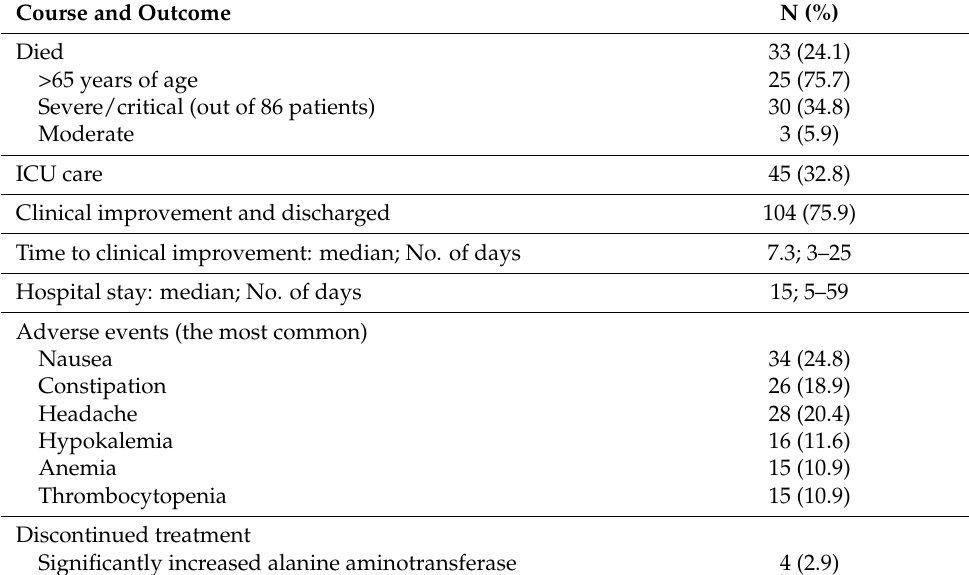
Table 2. Clinical course and outcomes of patients treated with remdesivir.